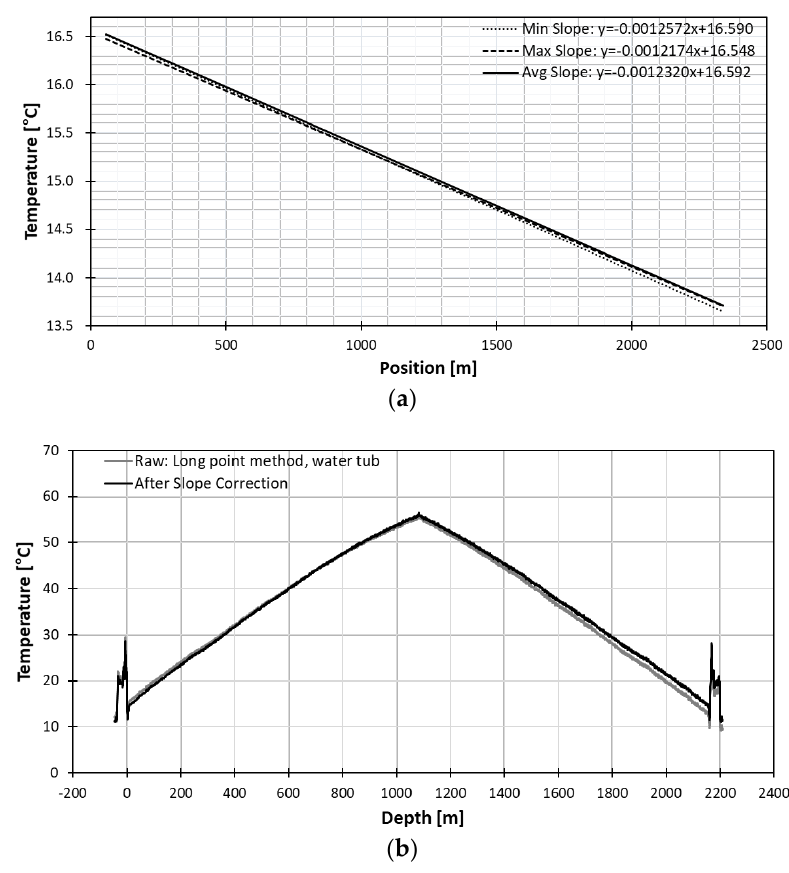
Figure 9. ( a ) Slope curve of long point method with best 10-minute range of DTS 60-point average from 17:53 to 18:02 and ( b ) heat profile after long point water tub temperature correction.